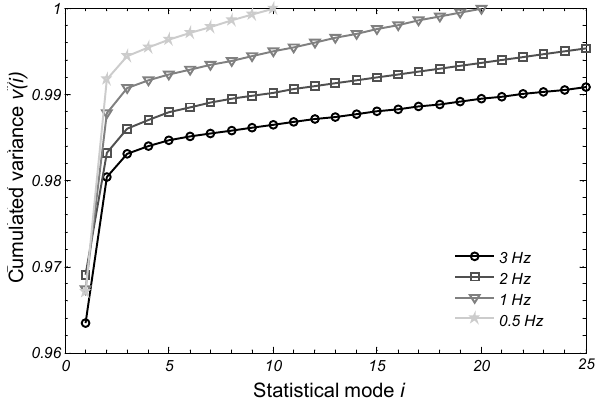
Figure 3. Cumulated and normalized variance ν EOF for the first 25 statistical